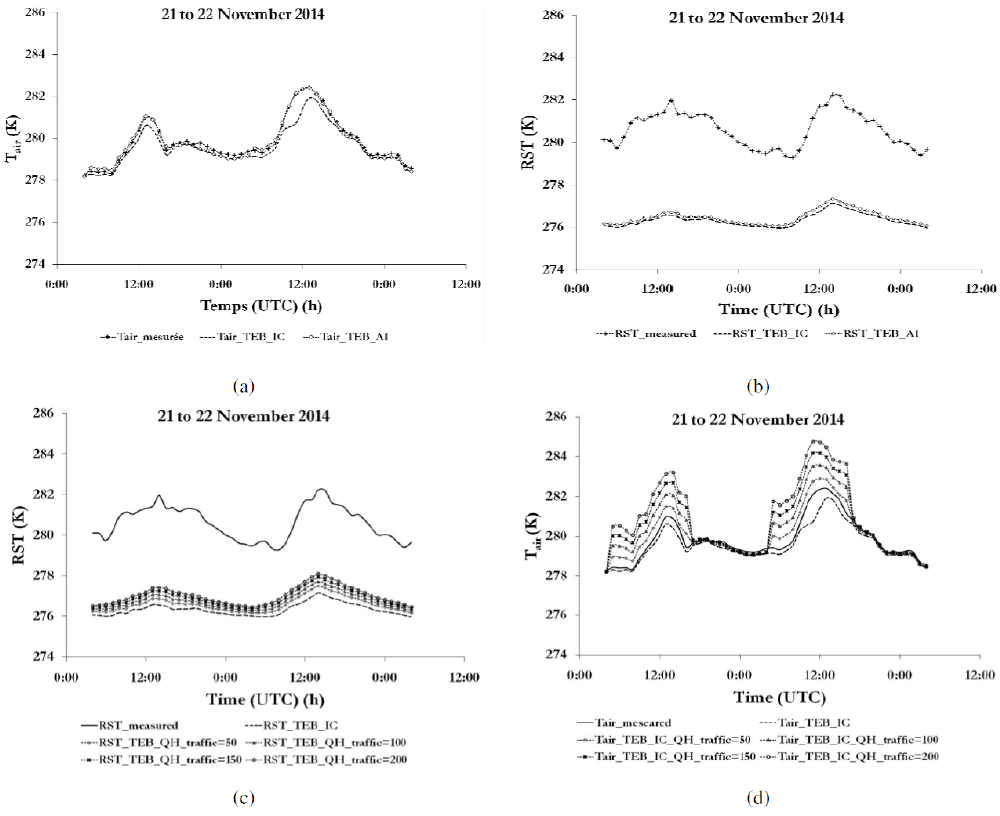
Figure 8. Comparisons between T air from TEB in its initial configuration (Tair_TEB_IC), T air from TEB via the first approach (Tair_TEB_A1) and field data (Tair_measured) (a) , between RST from TEB in its initial configuration (RST_TEB_IC), RST from TEB via the first approach (RST_TEB_A1) and field data (RST_measured) (b) , evaluation of the incidence of the traffic energy flux value on RST from TEB in its initial configuration (c) , and disruption induced on Tair forecast from TEB in its initial configuration with larger values of QH_traffic (d) for the first